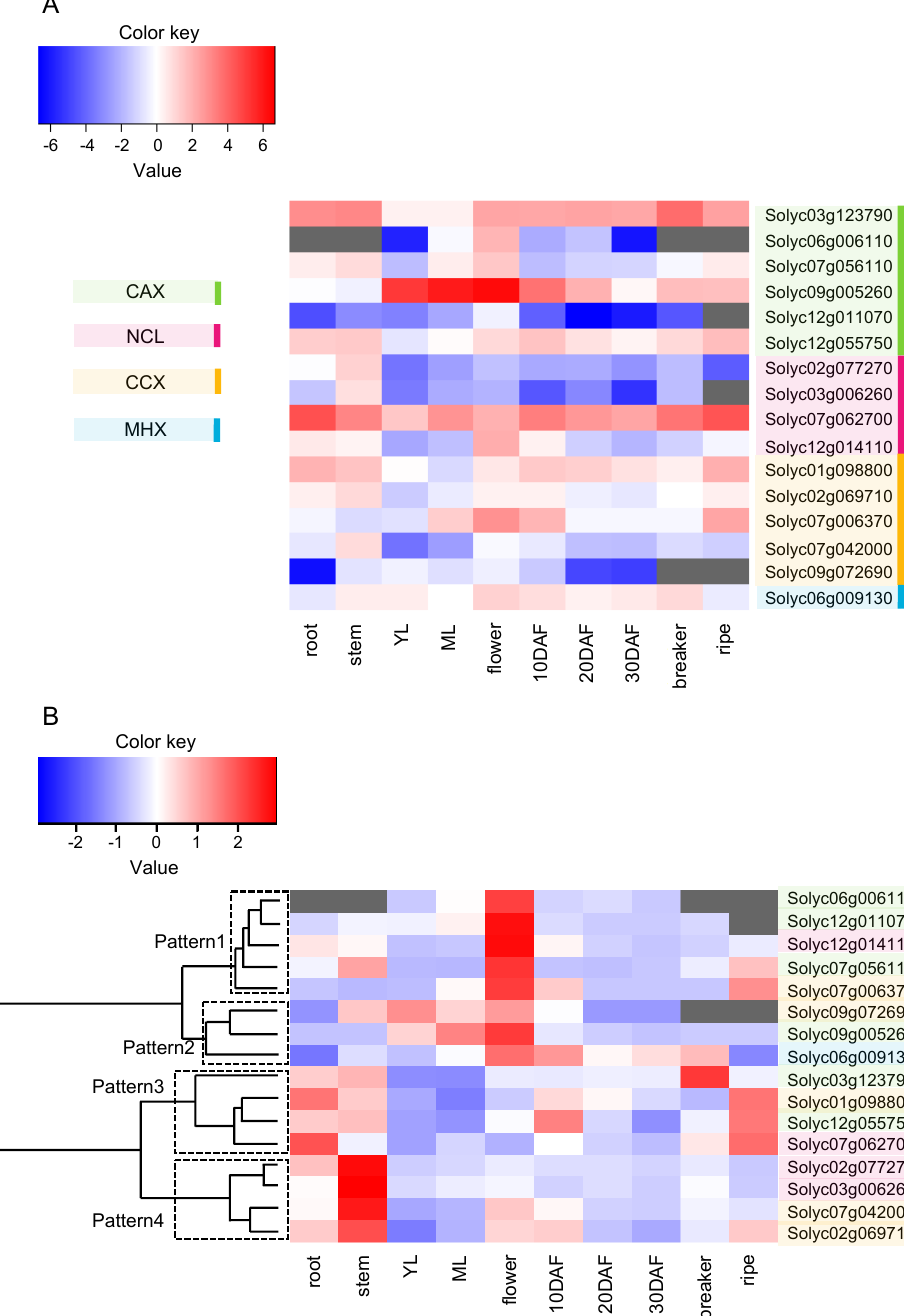
Figure 4. Expression profile of SlCaCA superfamily genes in various organs containing fruit from 10 days after flowering (DAF) to ripeness. YL and ML represent young and mature leaves, respectively. ( A ) In order to accurately compare the expression levels between genes, the copy number corresponding to the amount of each mRNA was determined using the standard curve. The expression level was expressed as log 2 , and the heat map was prepared by subtracting the expression level of each gene from the median; red represents the highest expression levels, white indicates median expression, and blue shows the lowest expression levels. Gray represents undetectable expression. Each log 2 expression value was based on the mean of three biological replicates. ( B ) To compare the expression levels among organs for each gene, expression levels were normalized in each gene. Color bar denotes Z-score: red represents the highest expression levels, white indicates mean expression, and blue shows the lowest expression levels in each gene. Gray represents undetectable expression. Hierarchical clustering was performed using Ward’s method. Each expression value was based on the mean of three biological